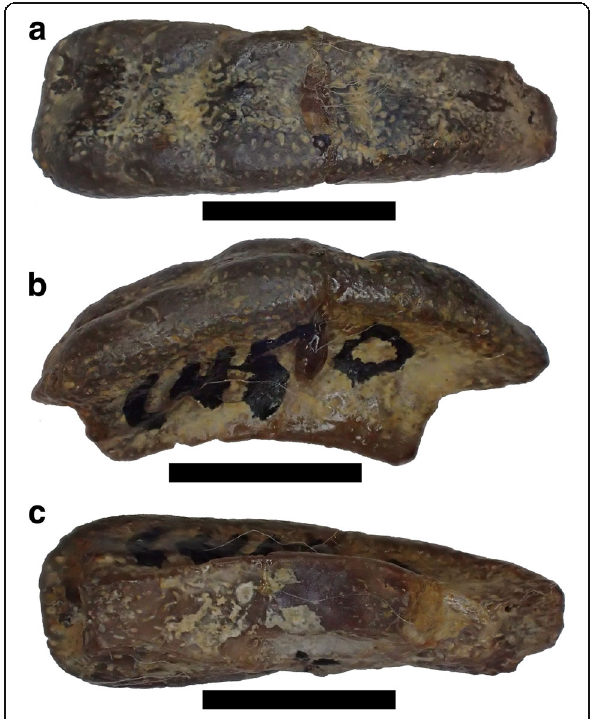
Fig. 7 Specimen referred to Deltodopsis ? bialveatus , AMNH FF6450. Here designated as Arcuodus bialveatus , comb. nov. a Occlusal view. Lingual end to left. Scale bar=5 mm. b Lateral view. Lingual end to left. Scale bar=5 mm. c Basal view. Scale bar =5 mm. Drawings published as Branson, 1906 ([32], pl. 41, figs.